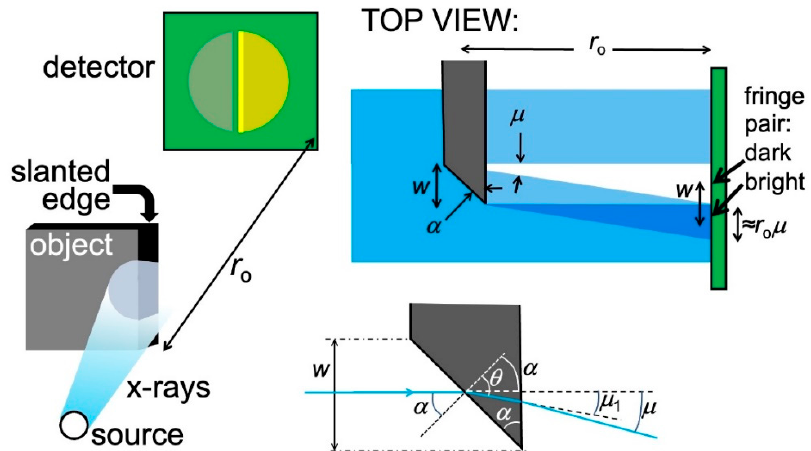
Figure 8. Left: refraction of X-rays passing through a slanted edge between an object and vacuum cause a characteristic pair of bright-fark fringes. A similar phenomenon occurs for a slanted edge separating two different object regions. Top right: analysis of the fringe geometry. Bottom right: enlarged scheme of the edge showing the parameters used ion the analysis.